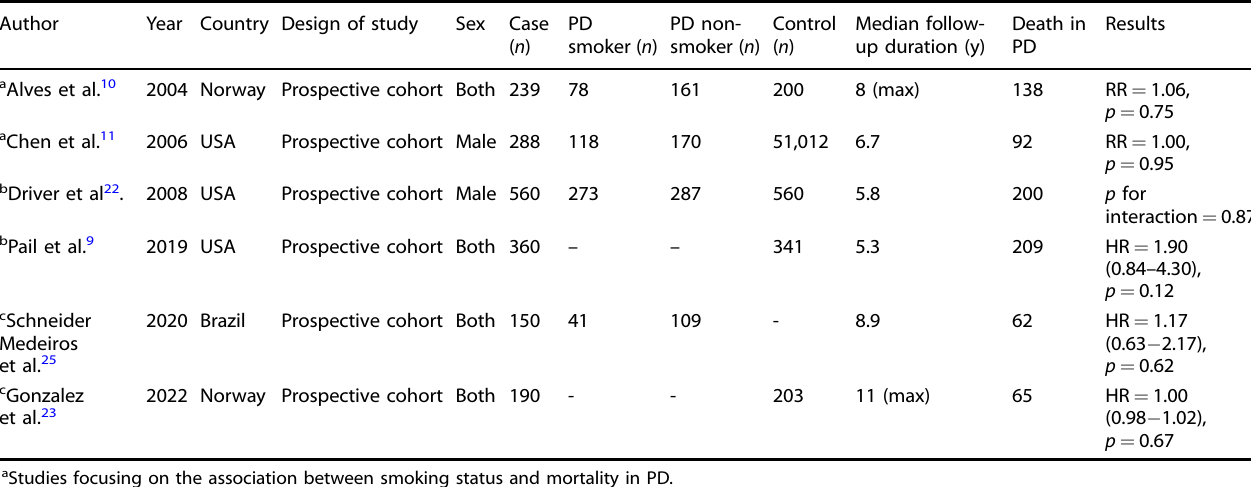
Table 4. Summary of studies included in the systematic